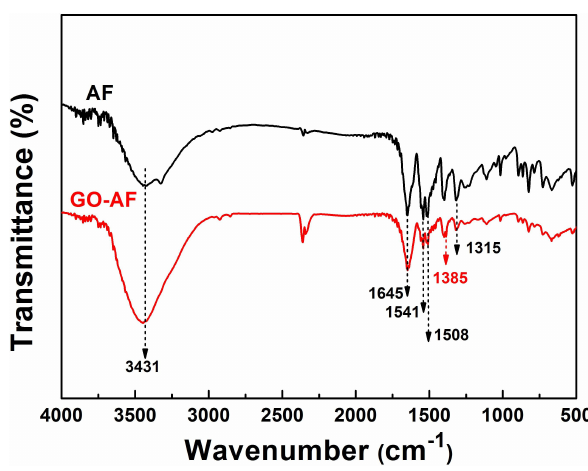
Figure 6: FTIR spectra of AF and